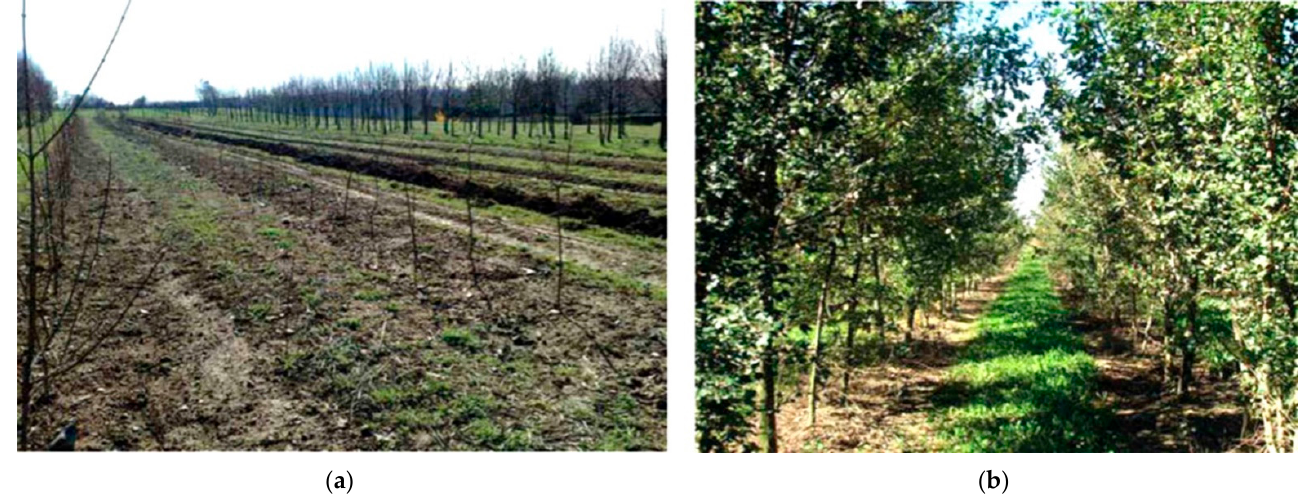
Figure A1. Experimental field: ( a ) immediately after transplanting; ( b ) three growing seasons after transplanting.